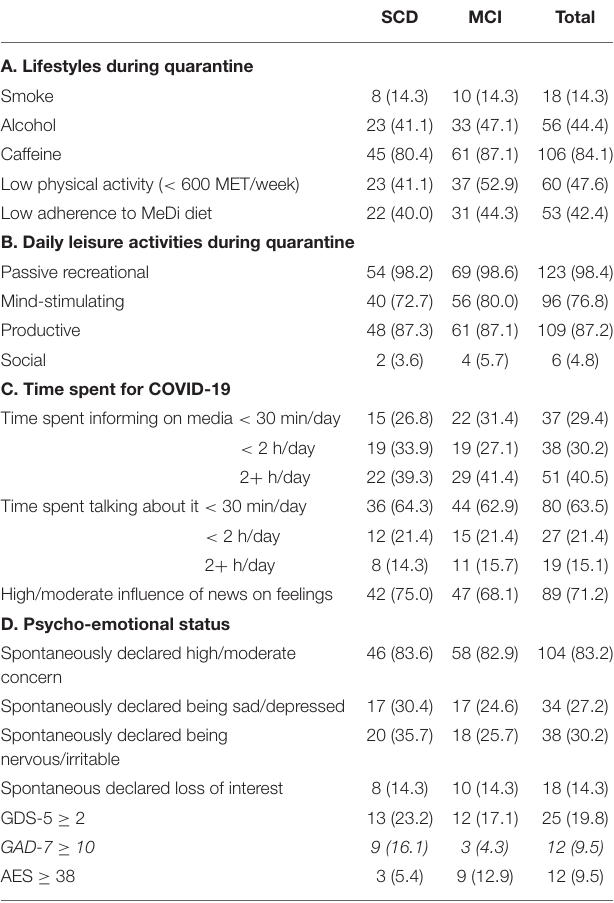
TABLE 3 | Lifestyles, behaviors and emotional state during quarantine, divided by